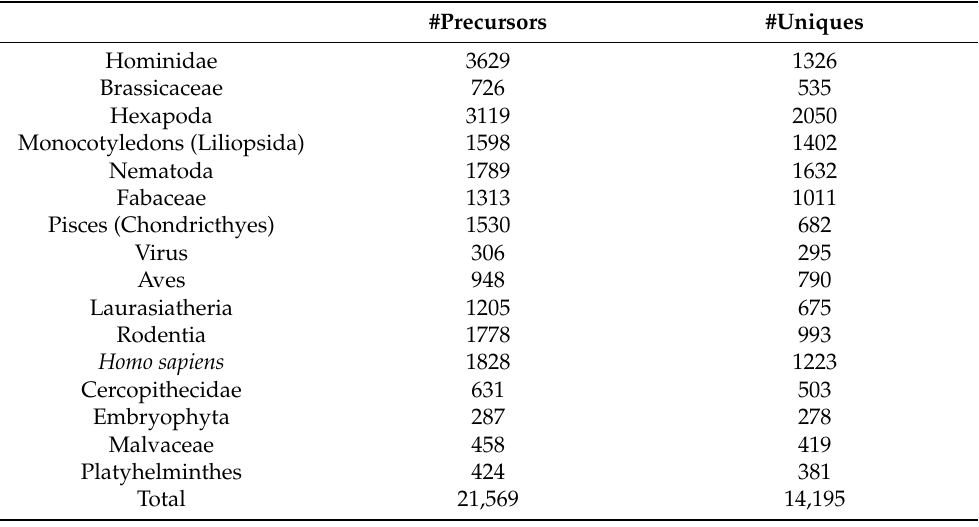
Table 1. The data used in this study derives from the clades listed in the first column. The number of precursors available in miRBase at the time of download is listed in the second column. The third column shows how many precursors survive the homology filtering. Since Homo sapiens is well studied, it contains many examples, and therefore it was extracted from its clade Hominidae. Clade names are from miRBase. If two names are provided, the name in parentheses refers to the NCBI